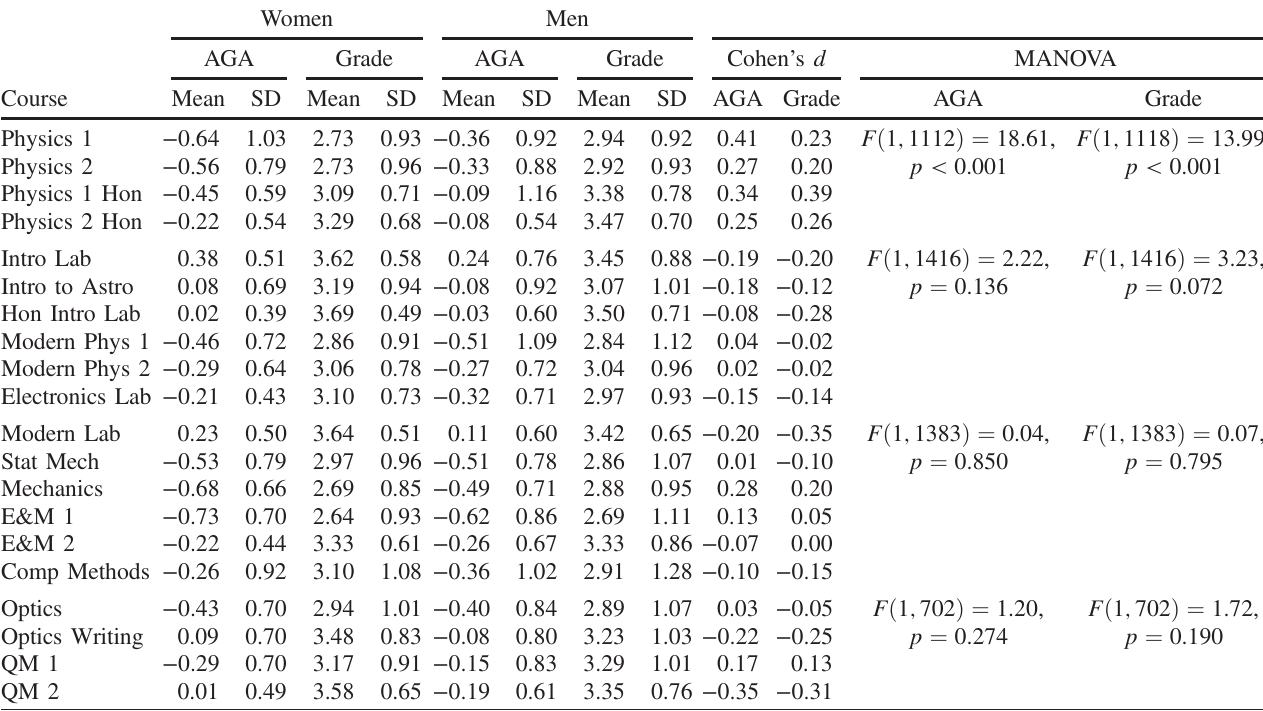
TABLE III. Average grade anomalies, grades, and effect sizes for both measures for each course of interest, by student gender. Cohen ’ s d is positive if the effect favored men (i.e., if men had higher grades than women in a course). Three MANOVA are reported, with courses grouped to reduce listwise deletion into courses typically taken in students ’ first, second, third, and fourth years in the physics program. We used the following abbreviations: Honors (Hon), Laboratory (Lab), Astronomy (Astro), Physics (Phys), Thermodynamics and Statistical Mechanics (Stat Mech), Electricity and Magnetism (E&M), Computational (Comp), and Quantum Mechanics